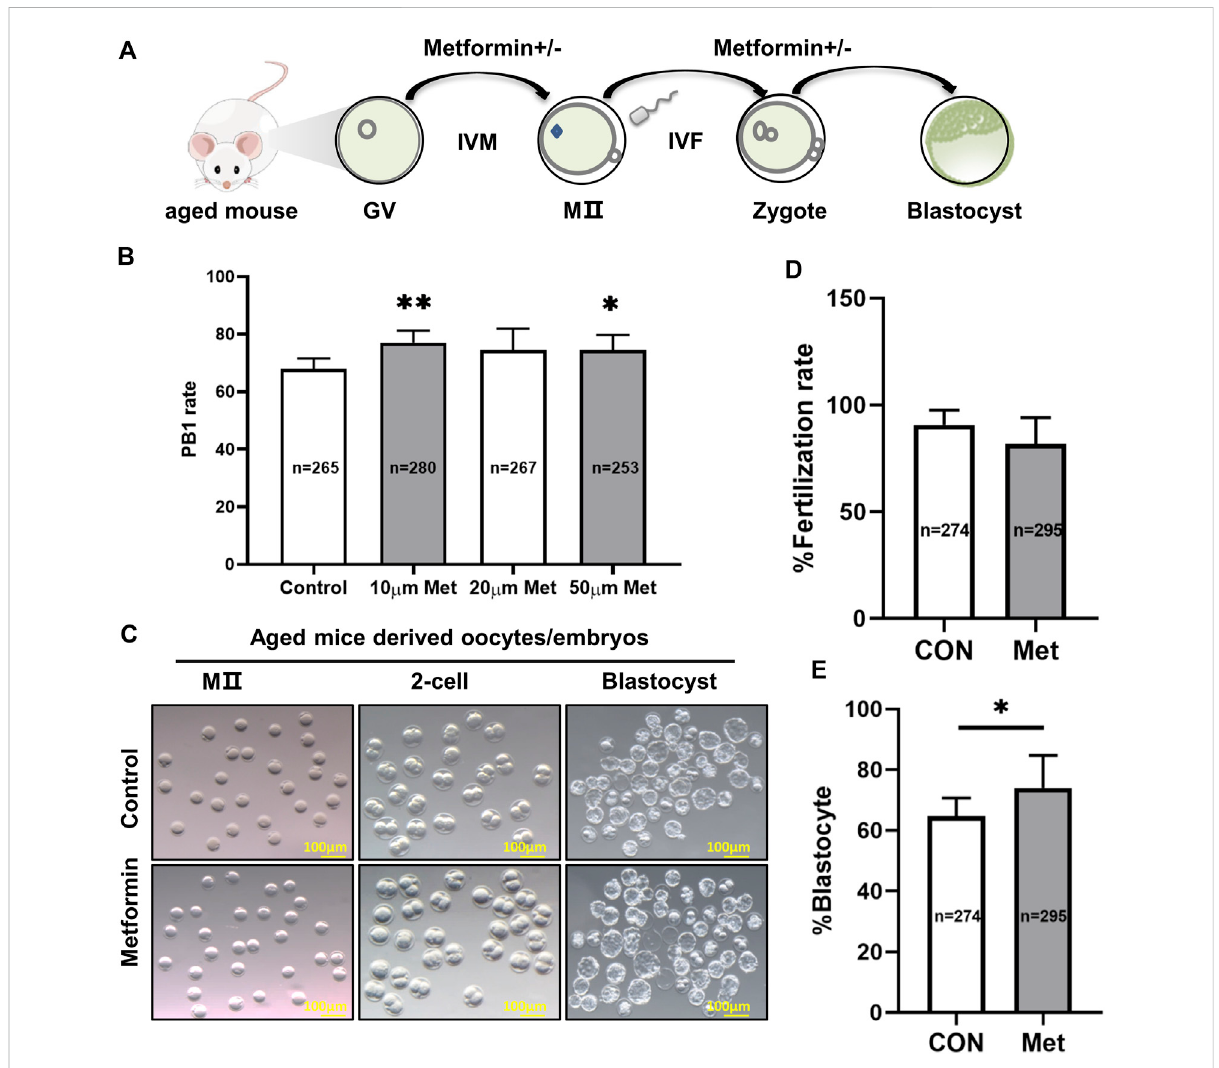
FIGURE 1 Treatment of oocytesfrom aged mice with metformin improves meiotic maturation and early embryonic development. (A) Schematicdiagram showing the design for assessing metformin-treated oocytes from aged mice maturation and early embryonic development (up to the blastocyst stage) in the M16 medium in vitro . (B) Quantitative analysis of PB1 extrusion in the concentrations of 0 μ M ( n = 180 oocytes), 10 μ M ( n = 215), 20 μ M ( n = 199), and 50 μ M ( n = 188) metformin. (C) Representative images of oocytes and embryos cultured in vitro at the MII, 2-cell, and blastocyst stages. Scale bar, 100 μ m. (D) Quantitative analysis of fertility rate with ( n = 295) or without ( n = 274) 10 μ M metformin treatment. (E) Quantitative analysis of the blastocyst formation rate with ( n = 295) or without ( n = 274)10 μ M metformin treatment. Data are means ± SD of at least